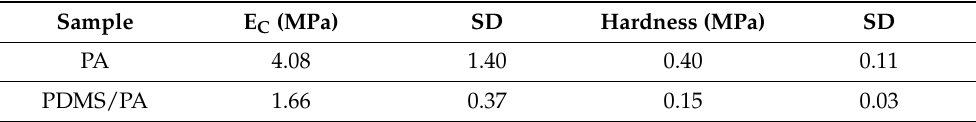
Table 3. The reduced Young’s modulus E C and the hardness of the electrospun fibers.